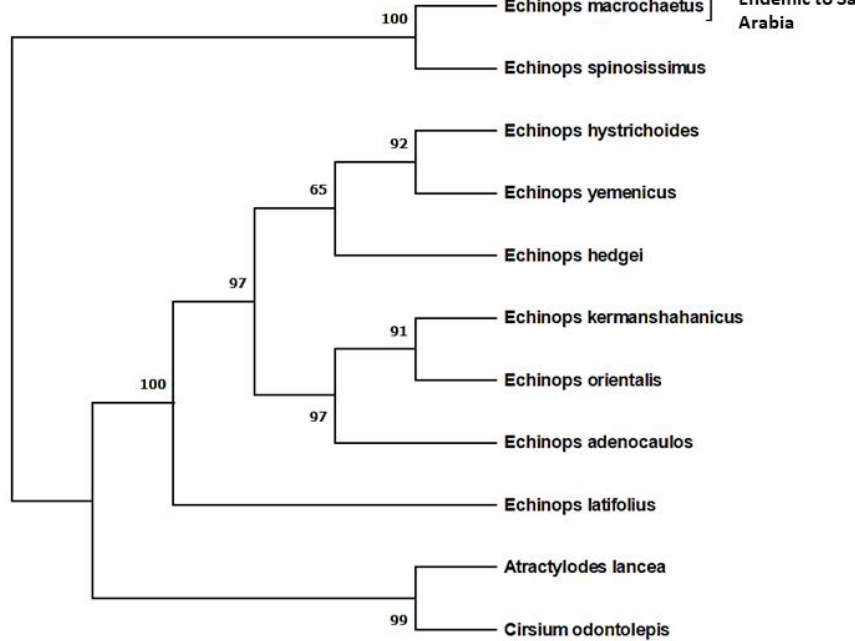
Figure 1. Phylogenetic reconstruction of Echinops macrochaetus with other species of Echinops using Maximum Parsimony method.